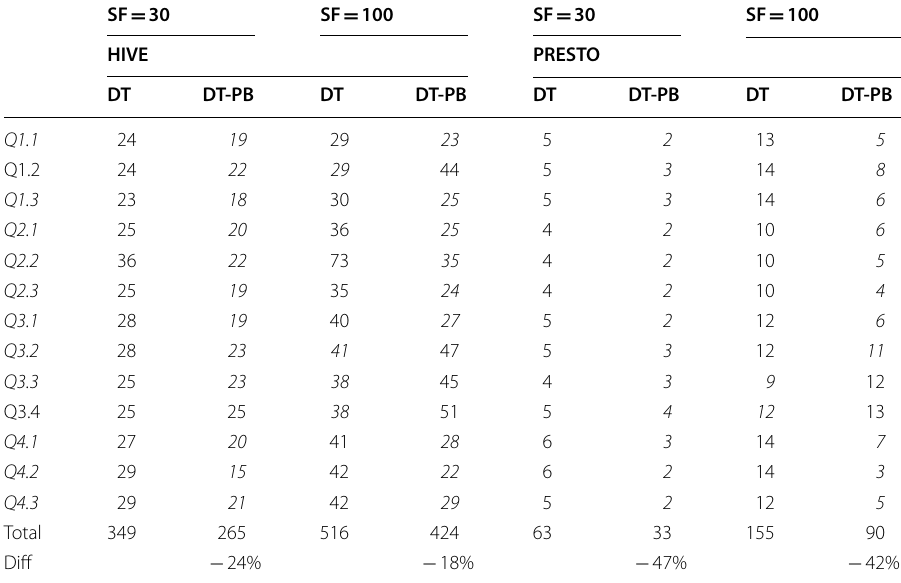
Table 13 SSB execution times (in seconds): partitioning by “Od_Year” and “S_Region” and bucketing by “Suppkey”. Retrieved from [10]